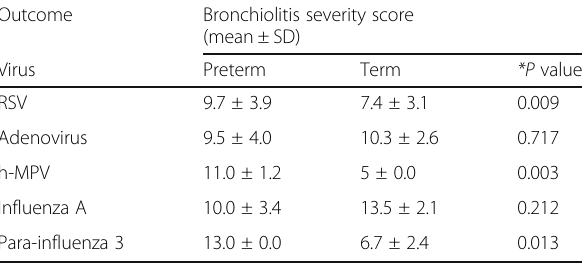
Table 4 Correlation between screened viruses and bronchiolitis severity score (BSS) in preterm and term infants